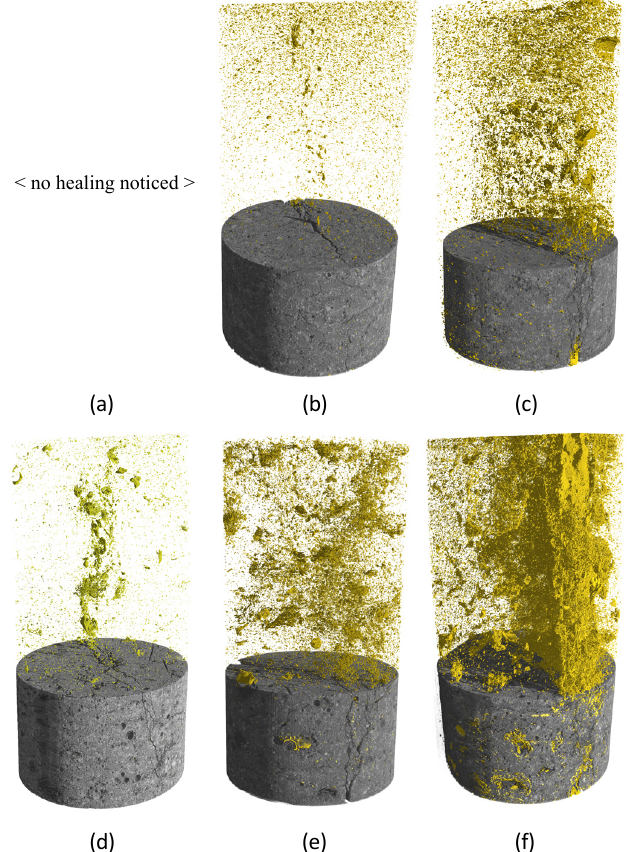
Figure 3. Amount of healing products (yellow) in 28 days old specimens without (a‐c) and with SAPs (d‐f) stored at a relative humidity of 60 ± 5% (a, d), 95 ± 5% (b, e) and in wet/dry cycles (c, f).